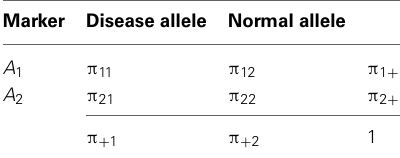
Table 1 | Layout and notation for population haplotypes, marker alleles, and disease allele frequencies in a 2 × 2